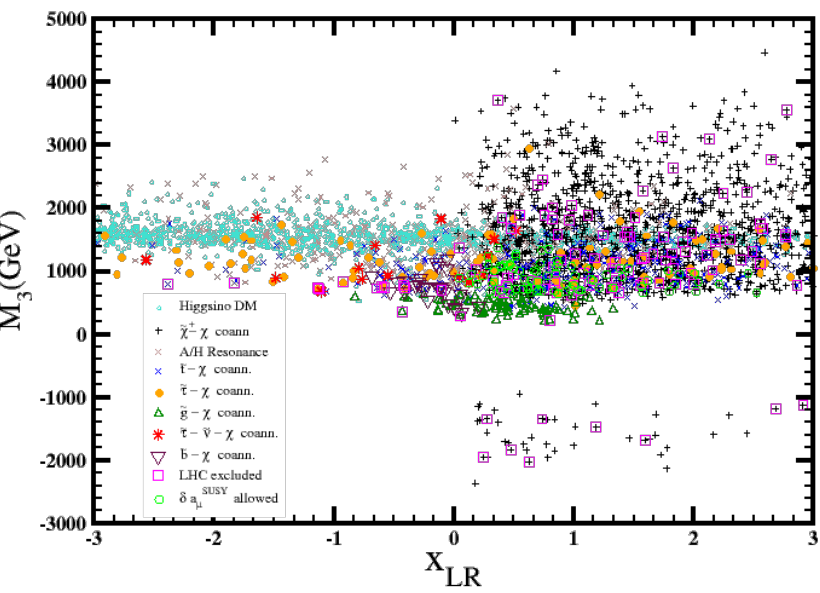
Figure 1 . Correlation of the WMAP allowed points with the GUT values of M 3 and the LR sfermion mass ratio. Di(cid:11)erent kinds of points are denoted with a symbol and color code that also will be maintained in the rest of the plots: Turquoise dots correspond to Higgsino DM, black crosses to (cid:31) (cid:6) (cid:0) (cid:31) coannihilations, brown crosses to A/H resonances, blue crosses to ~ t (cid:0) (cid:31) coannihilations, orange dots to ~ (cid:28) (cid:0) (cid:31) coannihilations, green up triangles to ~ g (cid:0) (cid:31) coannihilations, red stars to ~ (cid:28) (cid:0) ~ (cid:23) (cid:0) (cid:31) , and maroon down triangles to ~ b (cid:0) (cid:31) coannihilations. In addition, green circles enclose points